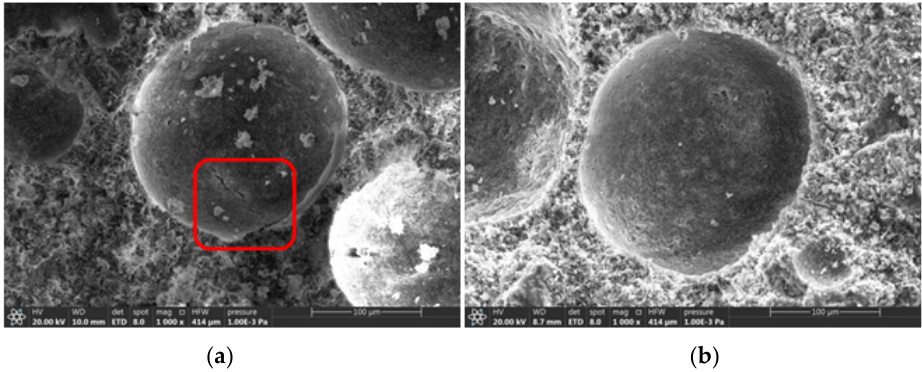
Figure 9. Drying shrinkage of foam concretes.